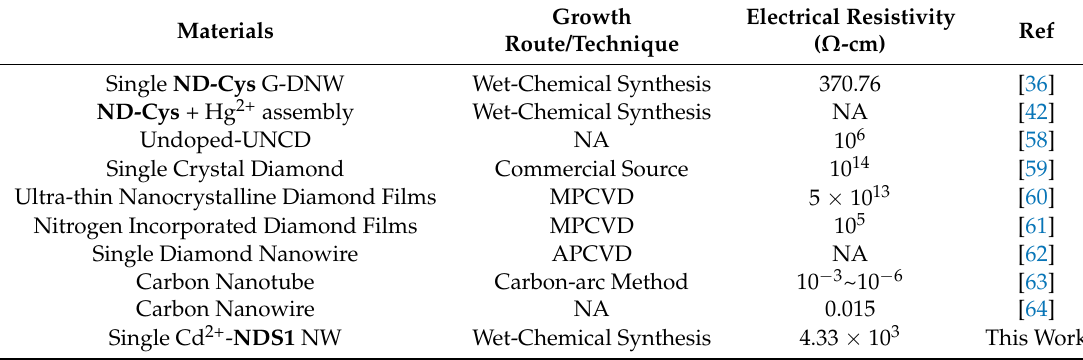
Table 3. Comparative account on electrical resistivities of Cd 2+ - NDS1 NW with respect to selected diamond materials, carbon nanotube and carbon nanowire from I-V